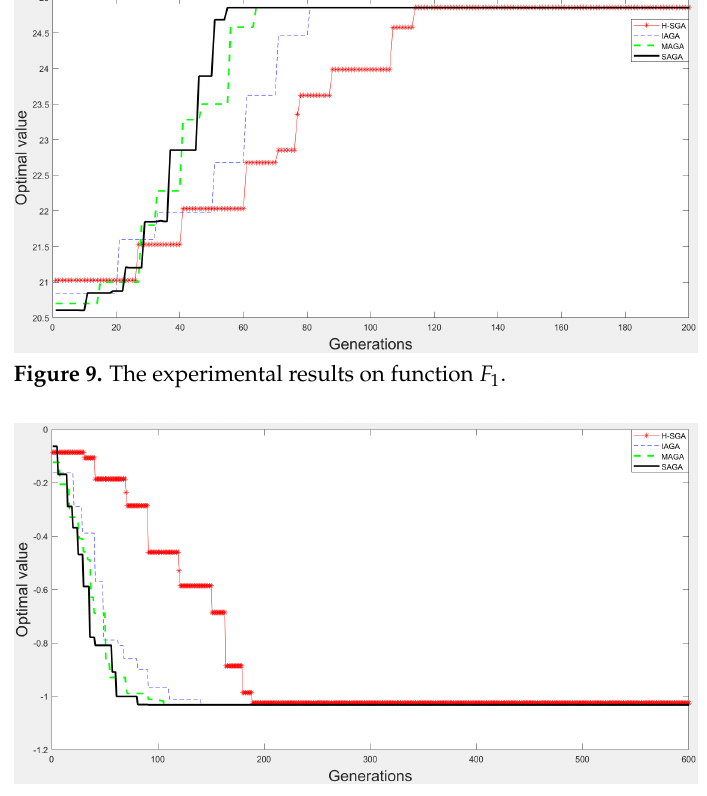
Figure 10. The experimental results on function F 2 .